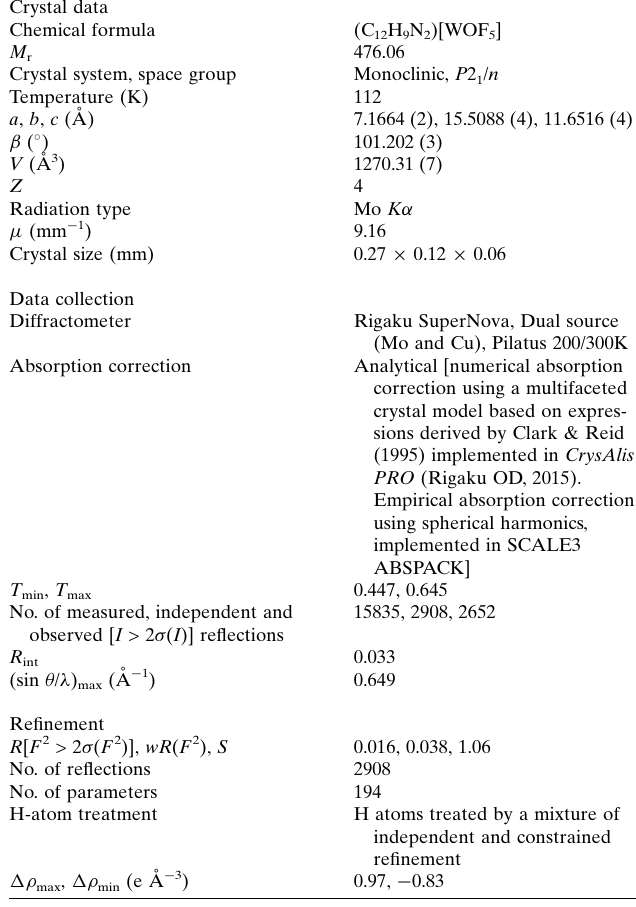
Table 3 Experimental details. Crystal data Chemical